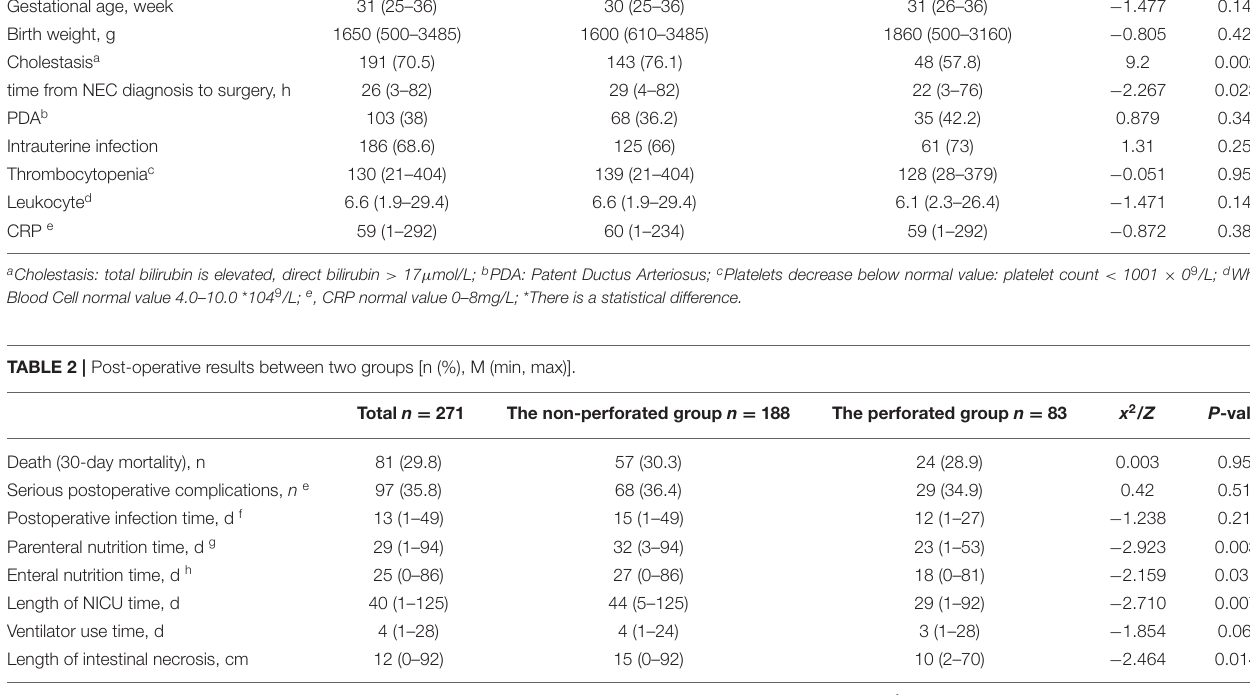
dose; * There is a statistical difference.